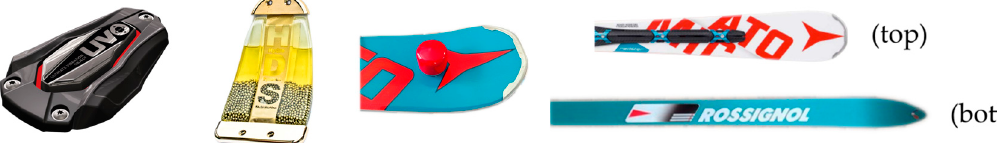
Figure 2. Ski damping devices from left to right: Völkl UVO [6], FloShocks [16], Hero Helper [17], Atomic Doubledeck [20] ( top ) and Rossignol VAS [19] ( bottom